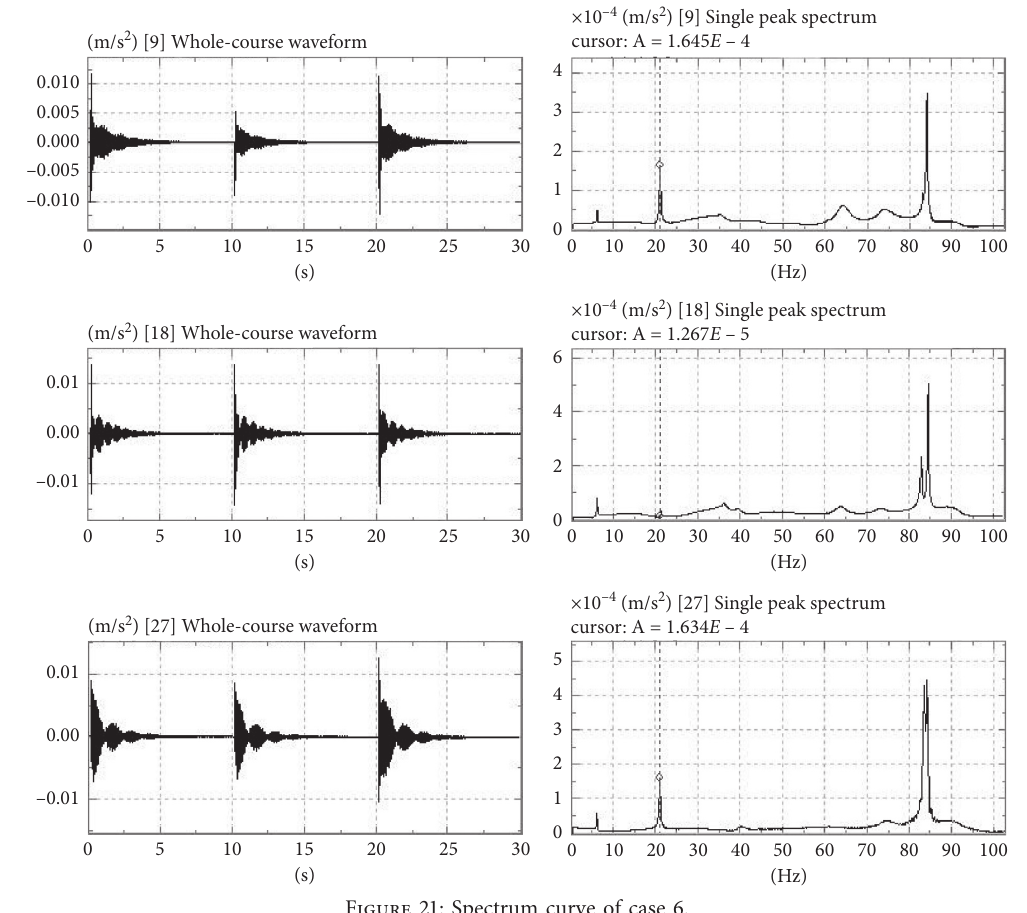
Figure 21: Spectrum curve of case